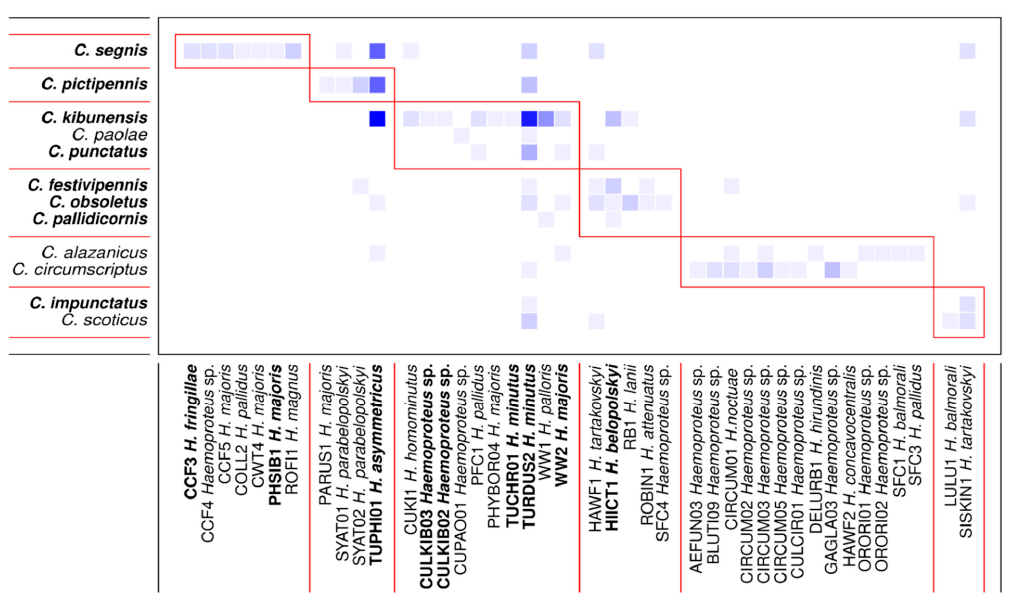
Figure 3. Modularity interaction network between Culicoides species (rows) and Haemoproteus lineages (columns). The blue squares represent the interactions between insects and parasites; the darker the square, the more often these interactions were registered. Culicoides species and Haemoproteus lineage investigated and found in this study are marked in bold. Red lines are separating different modules.